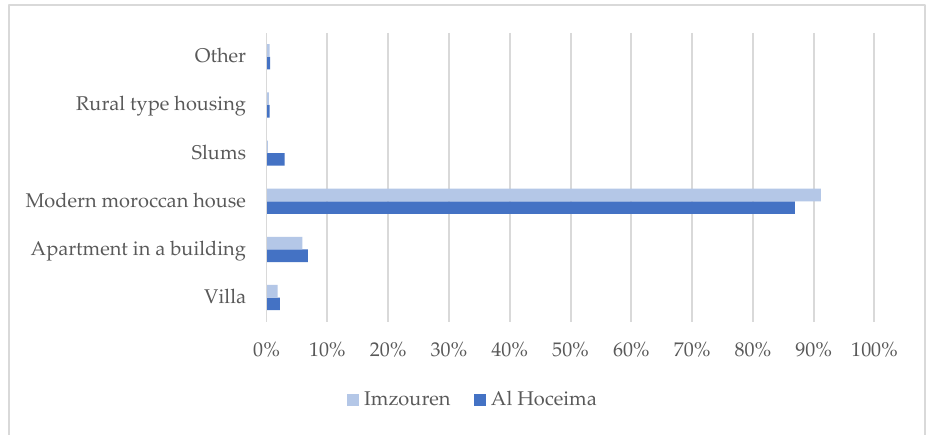
Figure 7. Distribution of building typologies in Al Hoceima and Imzouren of Central Rif [2].